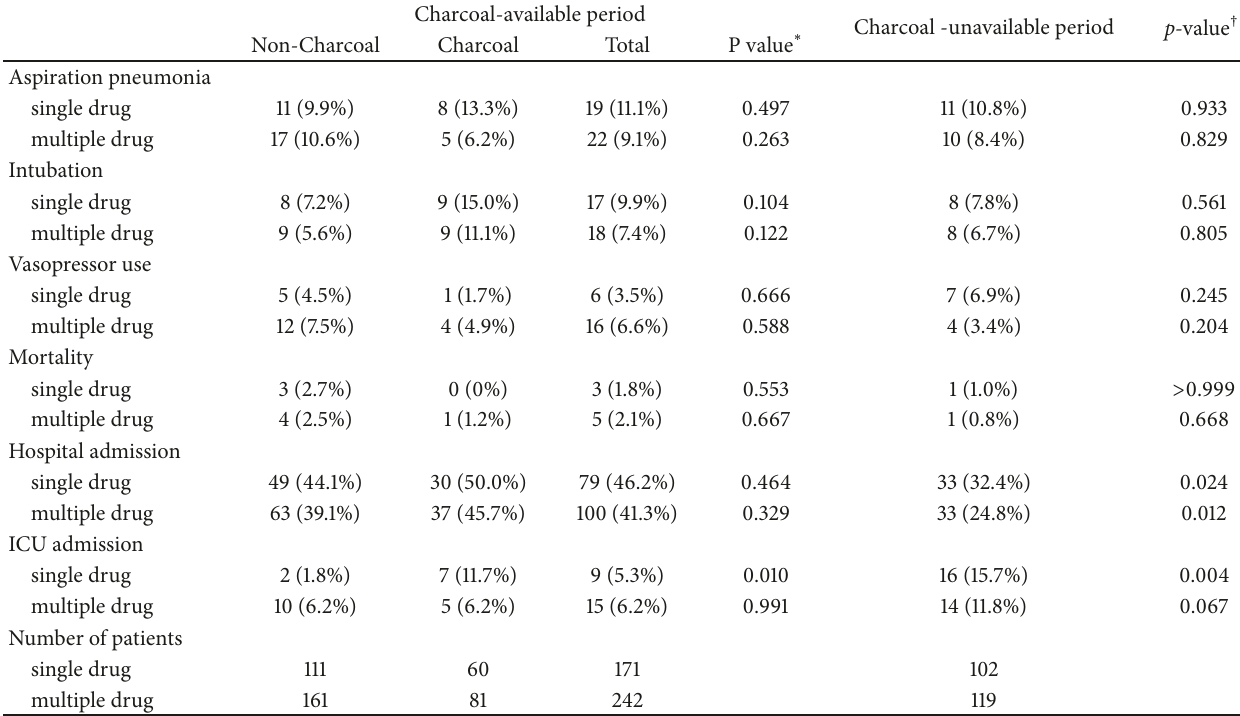
Table 5: Multiple-drug ingestion and clinical outcomes compared between charcoal-available and charcoal-unavailable periods. Charcoal-available period Charcoal -unavailable period